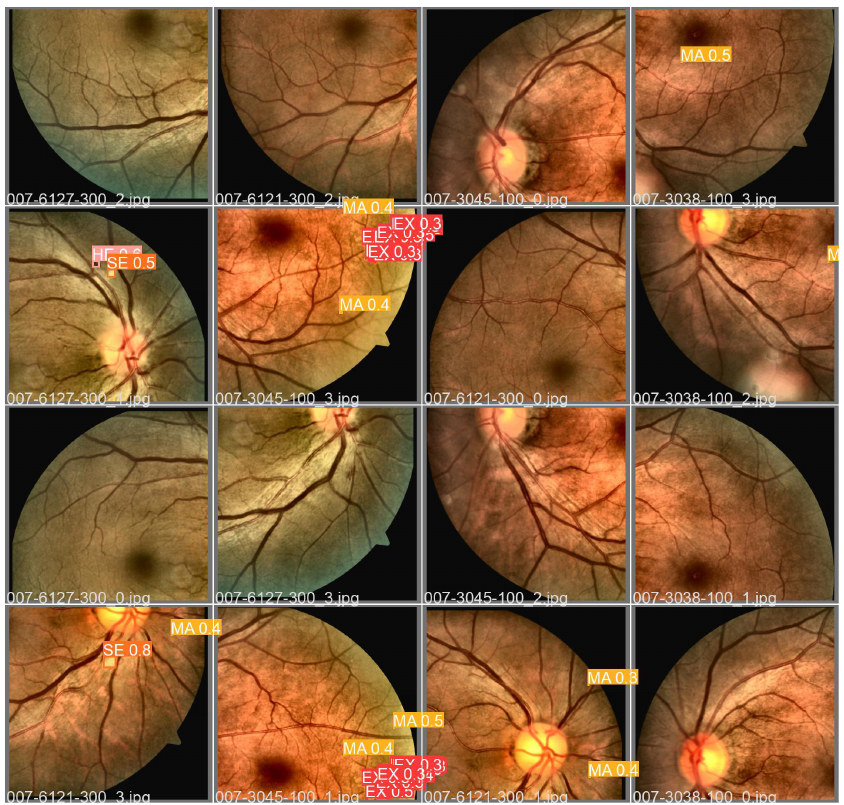
Figure 10. Batch with fundus images from the Dataset for Diabetic Retinopathy (DDR) with fundus lesions detected by the proposed approach during the validation step. MA, microaneurysms; HE, hemorrhages; SE, soft exudates; EX, hard